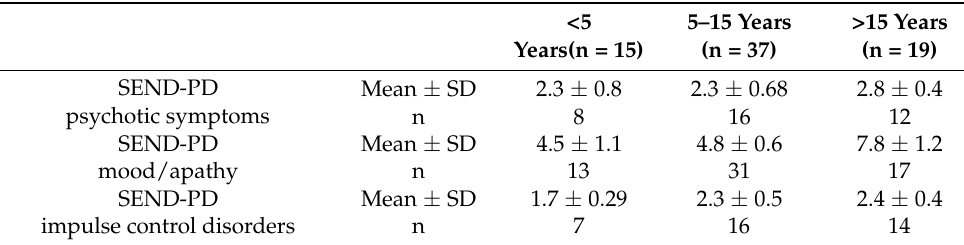
Table A1. Numbers of PwP and neuropsychiatric symptoms depending on disease